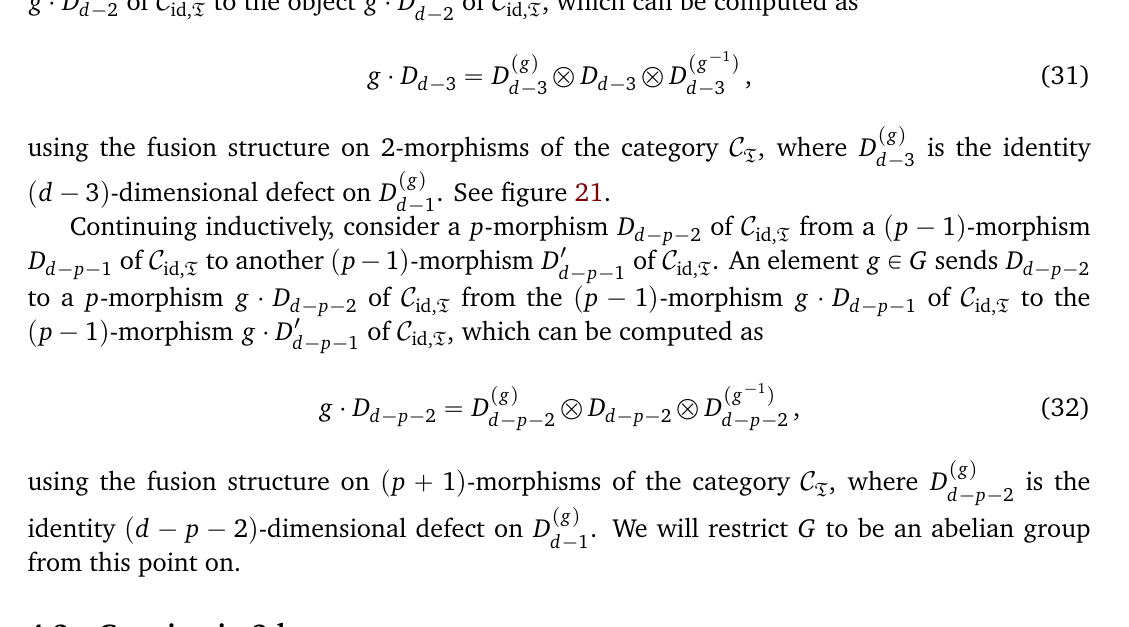
as in equation d ´ 3